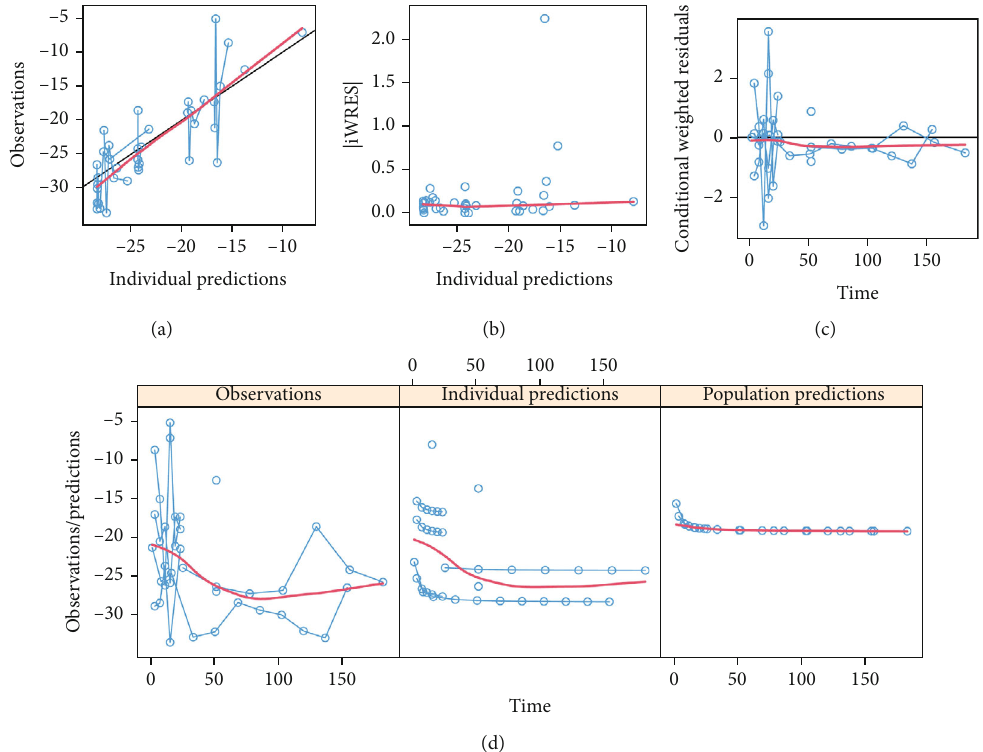
Figure 1: Model evaluation. (a) Observations vs. individual predictions, (b) absolute value of individual weighted residuals ( │ iWRES │ ) vs. individual predictions, (c) conditional weighted residuals (CWRES) vs. time, and (d) observations/predictions vs.